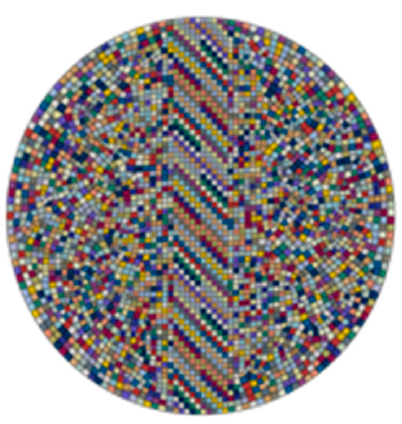
Figure 9. Weibull Figure 9. Weibull distribution.